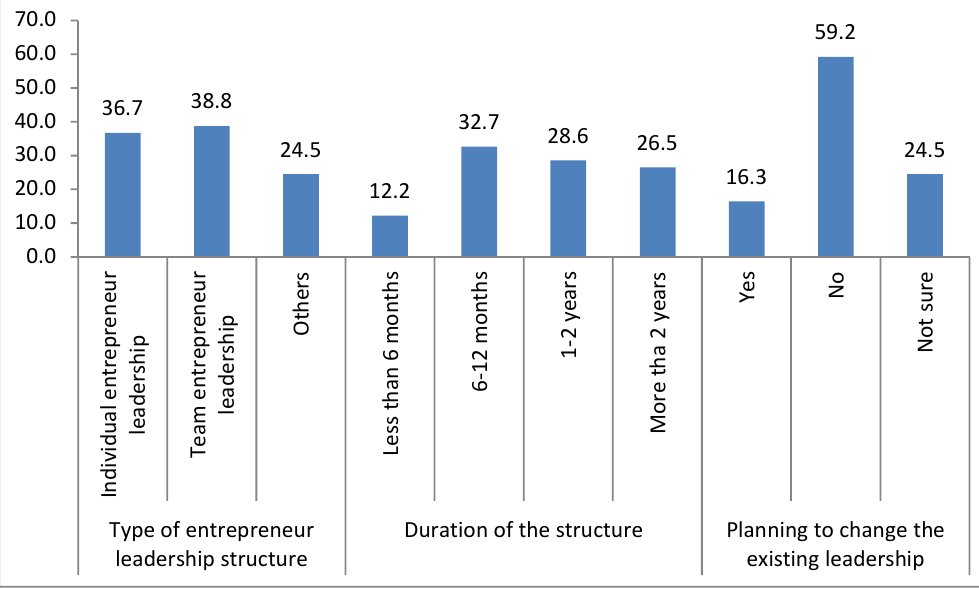
Fig. 3. Frequency distribution of general